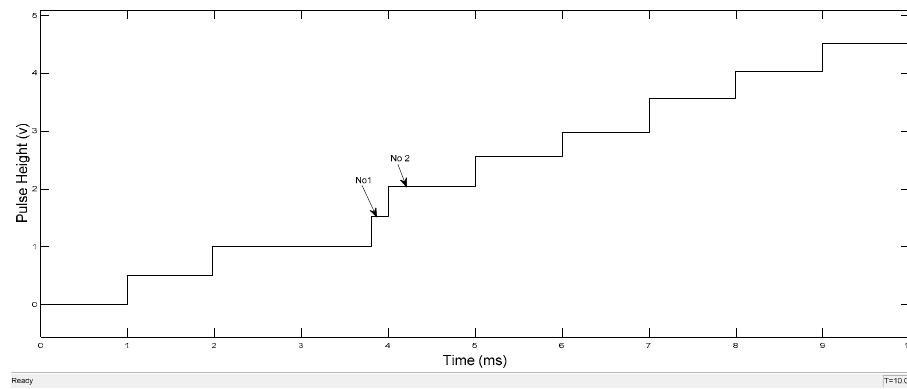
Figure 10. Detector equivalent outputs corresponding to pile-up 2.